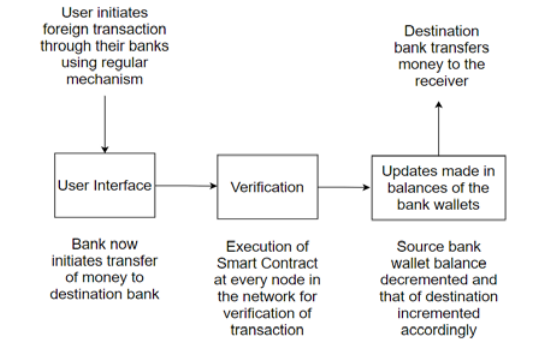
Figure 1: Block diagram